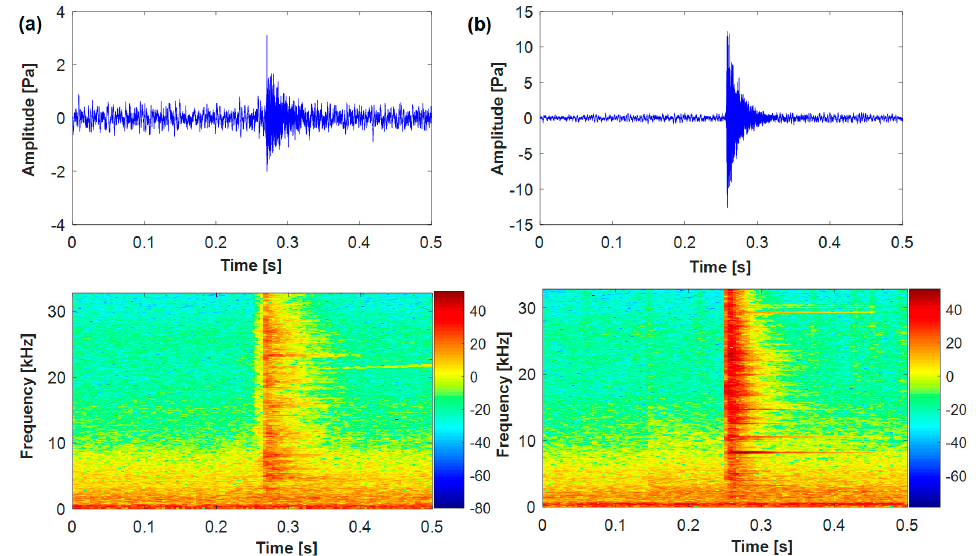
Figure 2. The waveform and time-frequency representation. ( a ) Normal sound pulse; ( b ) cracked sound pulse.